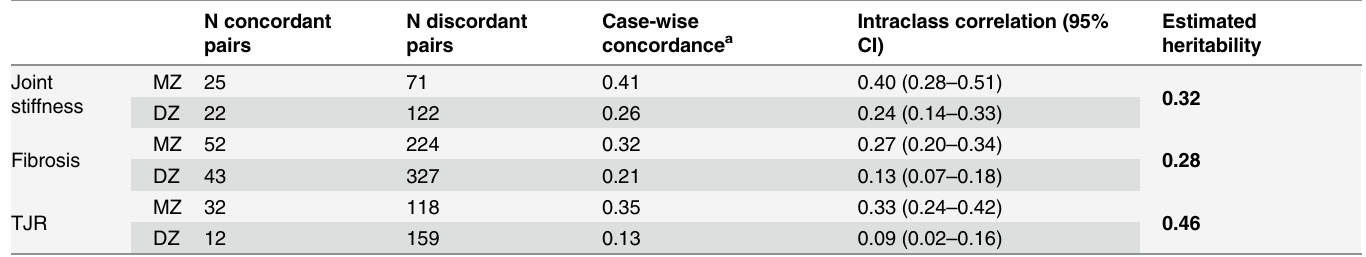
Table 3. Case-wise concordance, intraclass correlations and heritabilities for joint stiffness, fibrotic conditions and TJR. N concordant